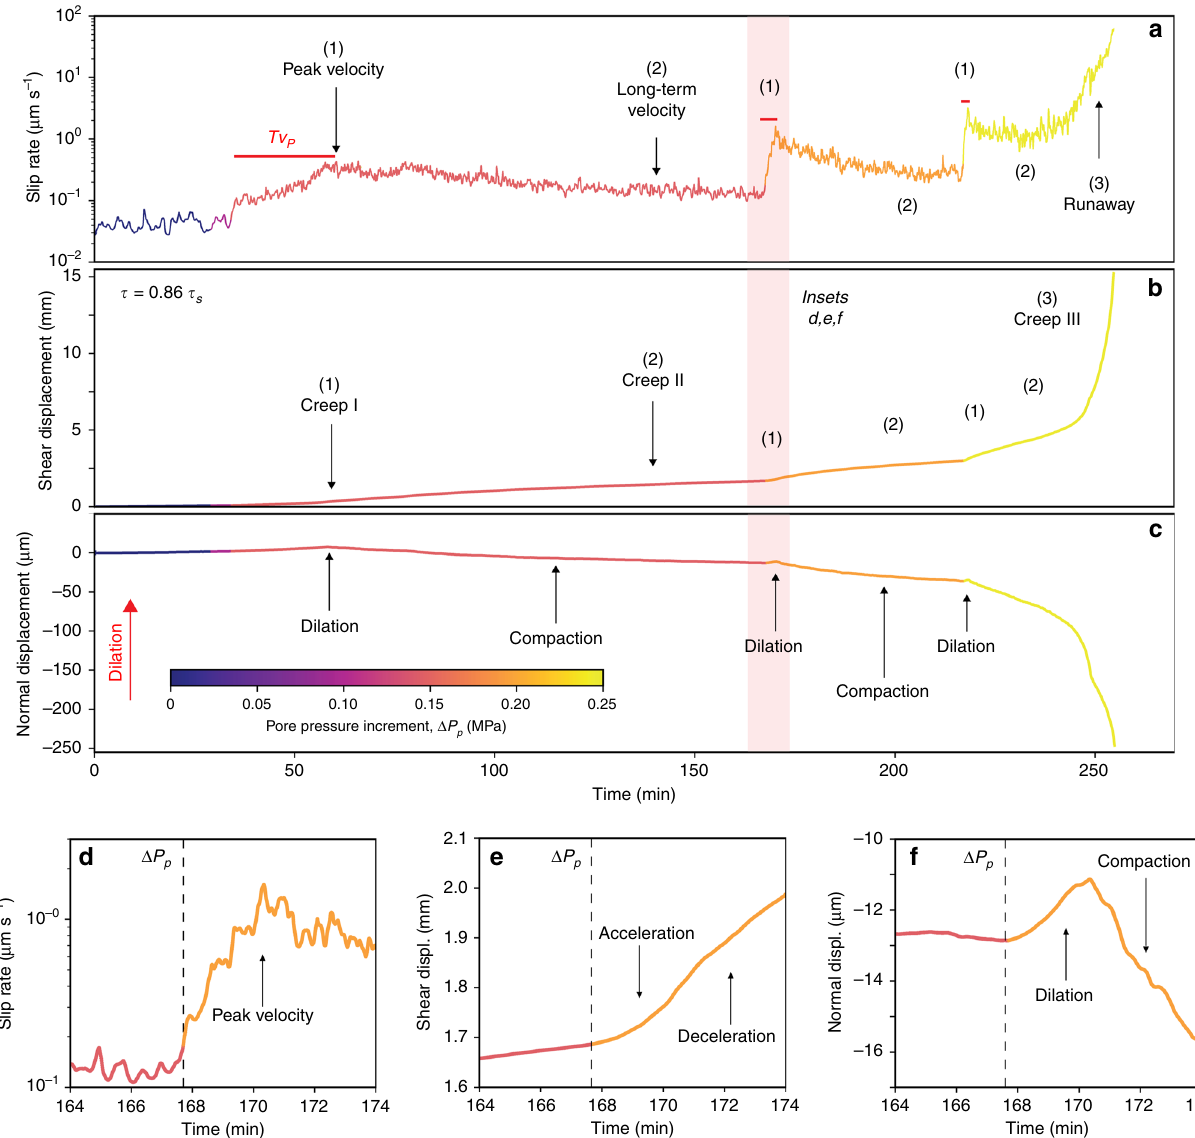
Fig. 3 Shear zone evolution during laboratory pore pressure-step creep experiment ( τ = 0.86 τ s ). Plots of a slip (shear displacement) rate, b cumulative shear displacement, and c normal displacement versus experiment time. The red bars in the fi rst panel of the fi gure mark the time required to reach peak slip velocity ( TV P ) following a pore-pressure step. The numbers highlight: (1) peak velocity followed by the onset of Creep I, (2) long-term steady slip, i.e., Creep II; (3) accelerated creep, i.e., Creep III; d – f details of one pressure step (pink shaded area in ( a – c )). The peak slip velocity is attained after some minutes from the pore-pressure step and then the shear zone decelerates. Acceleration is accompanied by shear zone dilation whereas deceleration results in compaction, illustrating the typical undrained response of the shear zone to a step of pore-pressure A rockslide deformation style, characterized by sudden term pore pressure variations at the shear zone level is quan- acceleration and self-deceleration following short-term events titatively consistent with laboratory results. We can observe this of pore pressure increase, has been observed both in situ consistency despite the spatial scale and complexity of the (Fig. 1c and Supplementary Table 1) and during laboratory natural system, that includes thick shear zones with variable experiments (Fig. 3). To compare the two datasets quantita- textural maturity and is affected by brittle deformation within tively, we used the following descriptors (Fig. 5a and Methods) the moving rockslide mass. Laboratory values of time to peak velocity (normalized T VP ; (Fig. 3, Supplementary Figs. 3 and 4): (a) time between Fig. 5b) decrease when pore pressure and mobilized shear pore pressure stepwise increment and the velocity peak ( TV P ); strength increase (Fig. 5b; statistics in Supplementary Table 2), (b) peak velocity ( V P ) associated to the acceleration impulse while experimental values of peak velocity ( V P , Fig. 5c) show occurring after each pore-pressure increase; (c) long-term strong positive correlations with pore-pressure increase (Spear- velocity ( V CII ) in the Creep II stage. The comparison of in situ man ’ s ρ reaching 0.8 – 1; Supplementary Table 2). Rockslide in situ and experimental rockslide behavior (Fig. 5b – d) demonstrates values of both T V and V P fall within the experimental bounds and follow the same general trends but are noisier and weakly that the hydro-mechanical response of the rockslide to short-